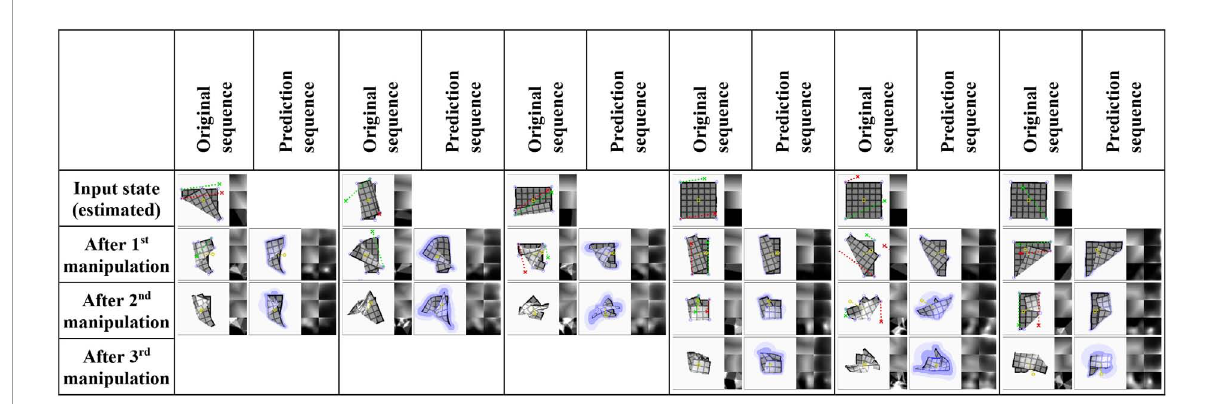
FIGURE7 Example prediction results for sequences of two and three manipulations (main experiment, test set data). Input for prediction is an estimation of the original sequence’s first state and the sequence of manipulation inputs. Red and green dotted lines show manipulation trajectories. Lilac circles mark grasp point candidates. Yellow dotted lines on predictions indicate the predicted displacement of the cloth’s centre point. Trajectories that extend outside the viewport are wrapped around the border for visualisation purposes. The last example shows a case where the system fails to predict that the shape partially unfolds during the last